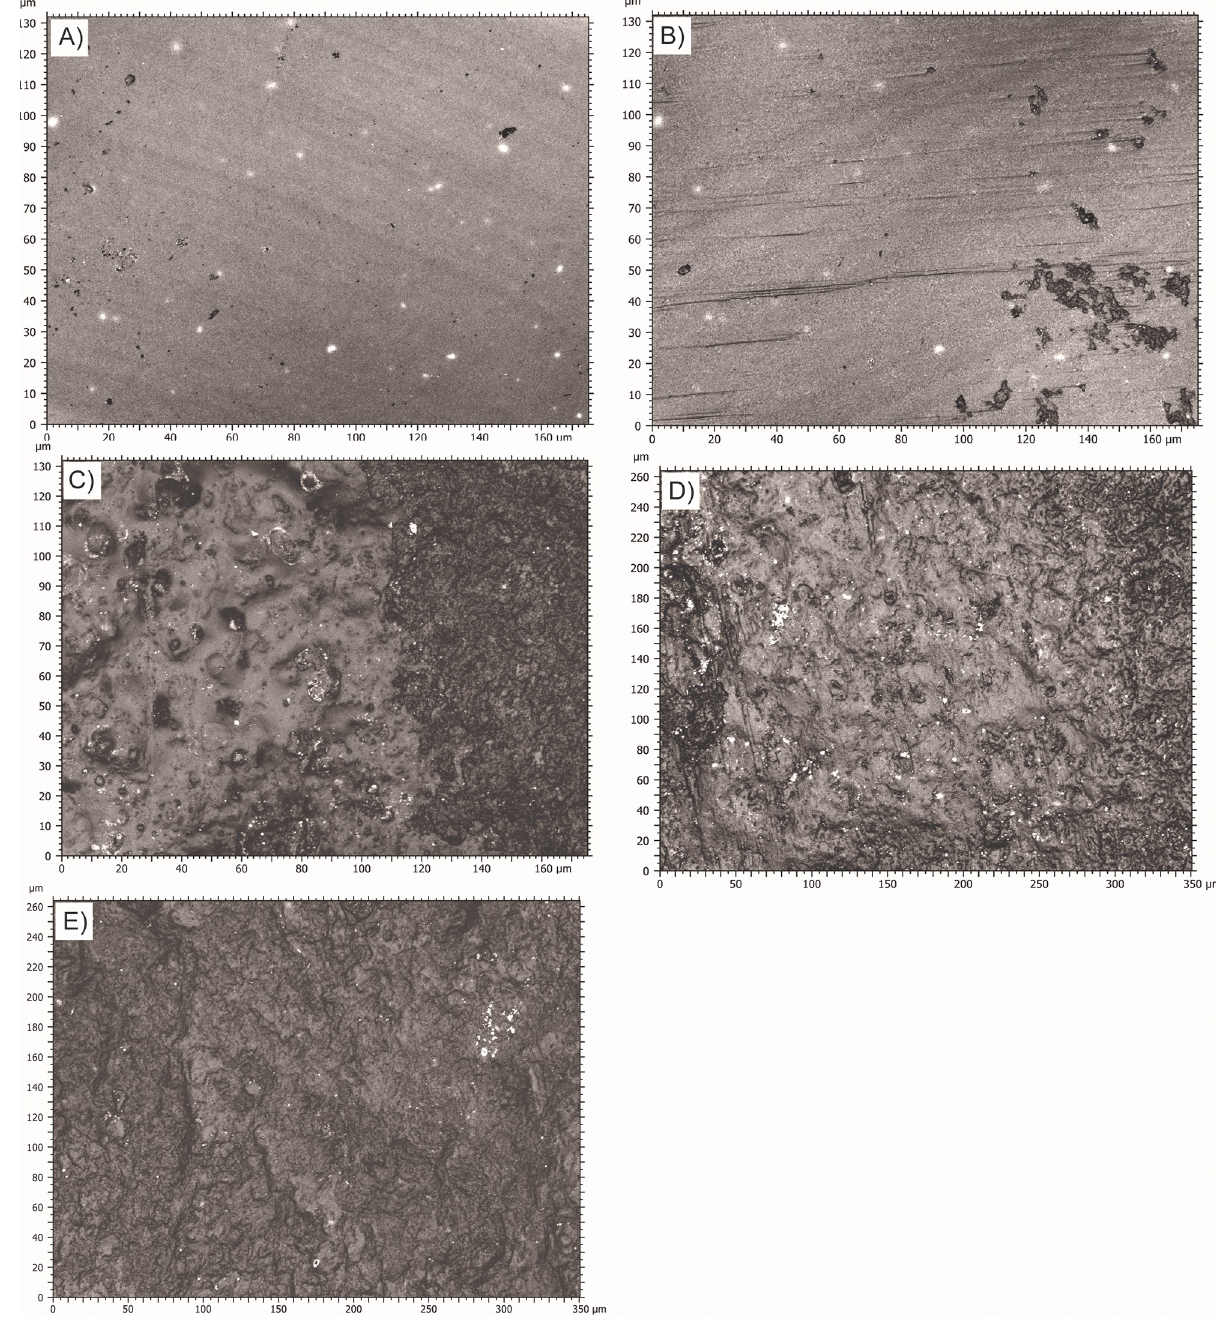
Fig 6. 100X pictures of the polished areas taken with the Sensofar. A) Surface modifications formed by rubbing the stone bit on Spruce wood. B) Surface modifications formed by rubbing the stone bit on Beech wood. C) Surface modifications formed by rubbing the stone bit on bone. D) Surface modifications formed by rubbing the stone bit on antler. E) Surface modifications formed by rubbing the stone bit on ivory.